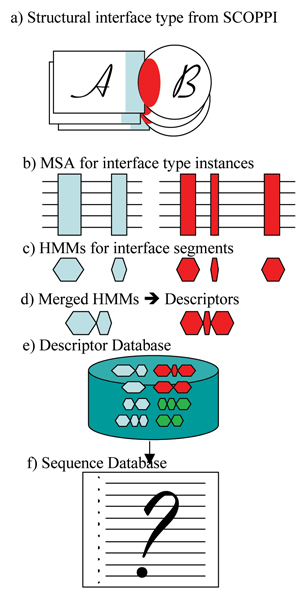
Work flow. a) All instances for interactions between family A and family B with identical geometric interface classification are retrieved from SCOPPI. Interface residues are indicated in the accompanying multiple sequence alignments. b) Interface columns are defined by columns with more than 50% interface residues. Interface segments are defined by including interface flanking columns. c) HMMs are constructed for each interface segment using HMMer's hmmbuild. d) HMMs are merged by insert states with high self-loop probabilities as to model the non-interacting linker region e) The collection of all merged HMMs constitutes the descriptor library. f) Sequence searches against Swiss-Prot and uncharacterized sequences with all descriptors were done using HMMer's hmmsearch